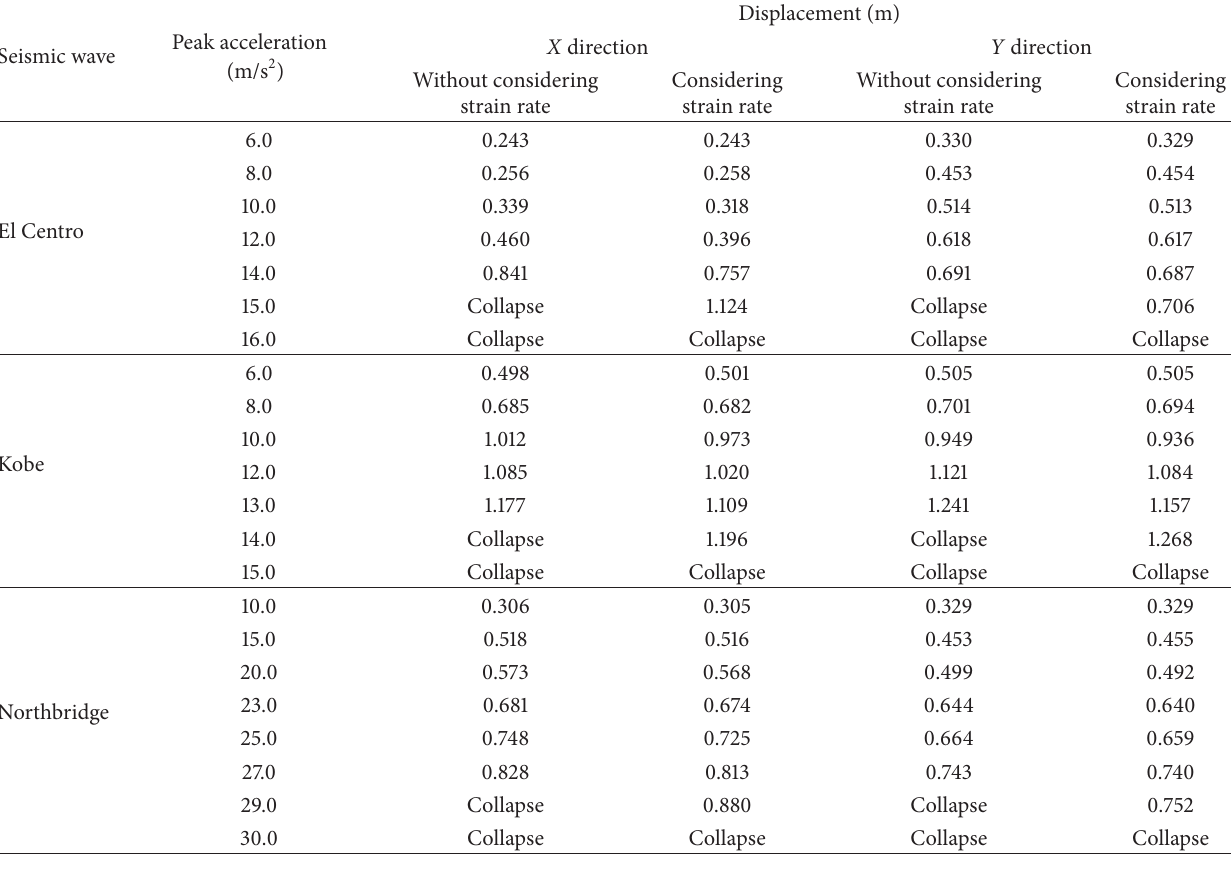
Table 3: Maximum top displacements of 2nd transmission tower.